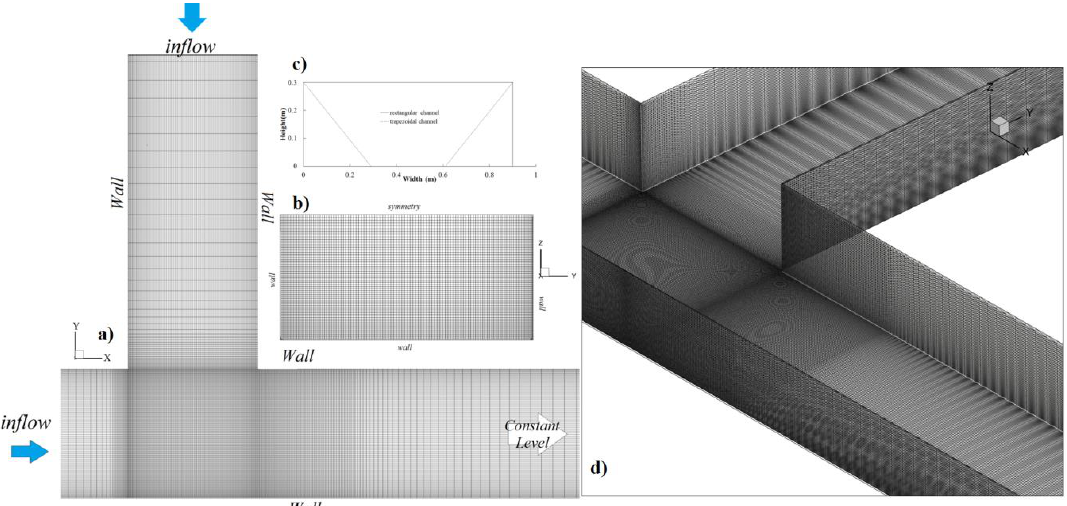
Figure 1. Plan of mesh ( a ) with boundary conditions and a cross-sectional view of mesh ( b ) and the cross-section geometries ( c ) and 3D view of the confluence and mesh domain ( d ).